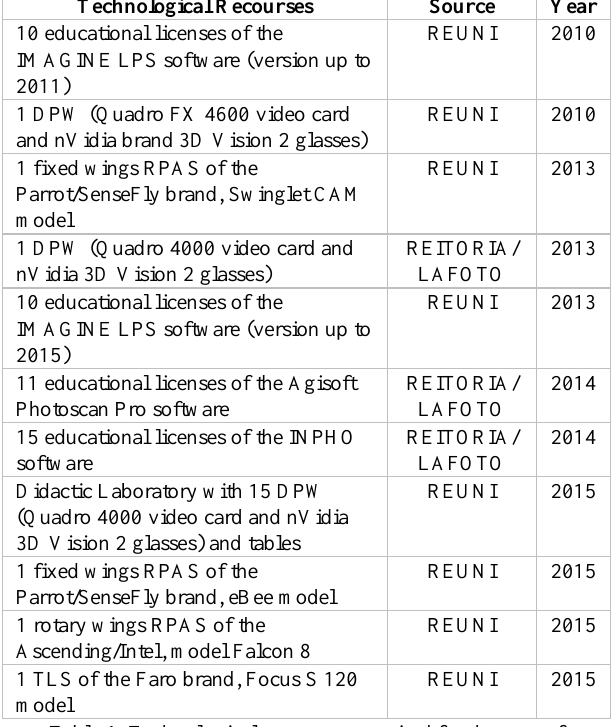
Table 1. Technological resources acquired for the area of Photogrammetry